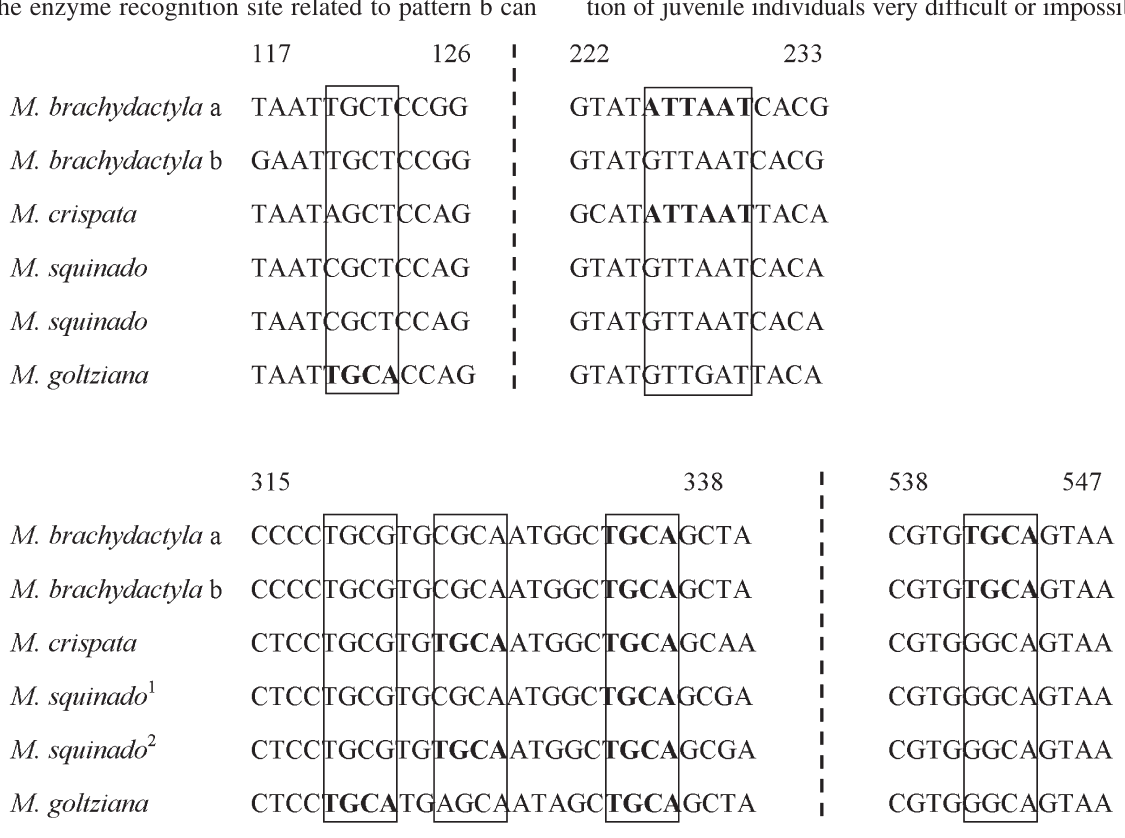
Fig . 4. – Position of Hpy CH4V and Ase I restriction sites on the COI segment. M. brachydactyla a, GU902708; M. brachydactyla b, GU902707; M. crispata , GU902710; M. squinado 1 , GU902709; M. squinado 2 , HM572326; M. goltziana ,